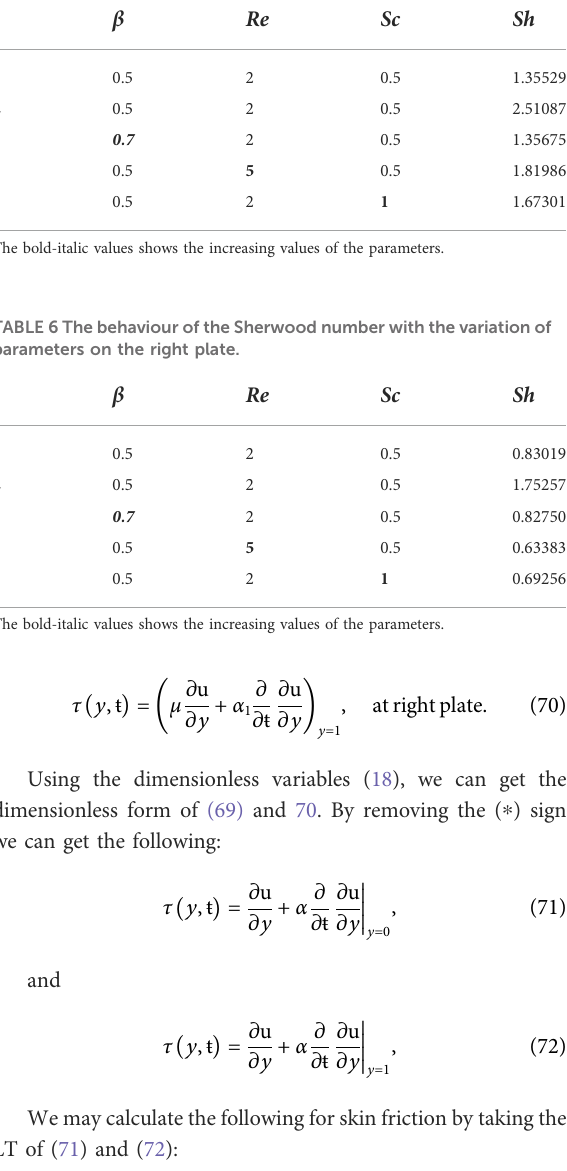
TABLE 5 The behaviour of the Sherwood number with the variation of parameters on the left plate.